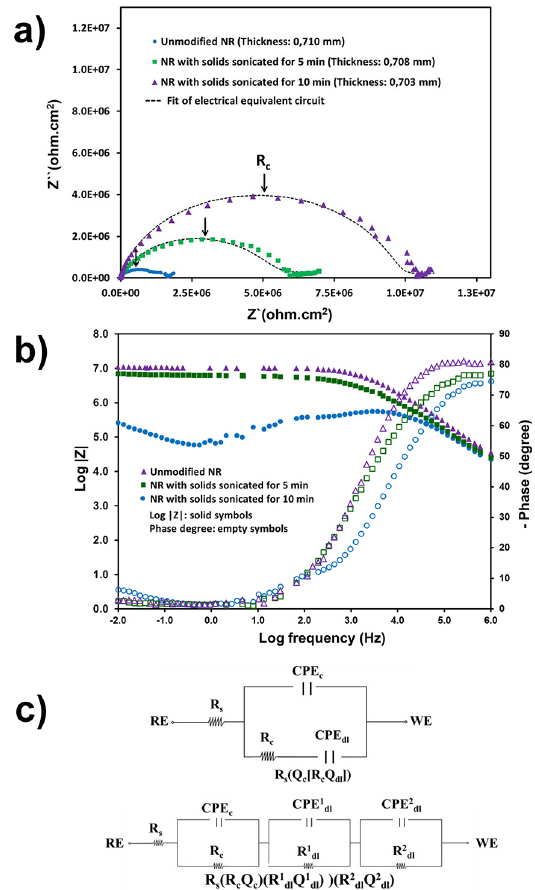
Figure 7. (a) Nyquist and (b) plots of unmodified NR films and NR films with nanometric particles of ZnO and TiO2 incorporated. In (c) the electrical equivalent circuit (EEC) used for fitting experimental data is depicted: (up) compounded NR with nanometric particles and (down) NR with industrial particle size grade, i.e . micrometric